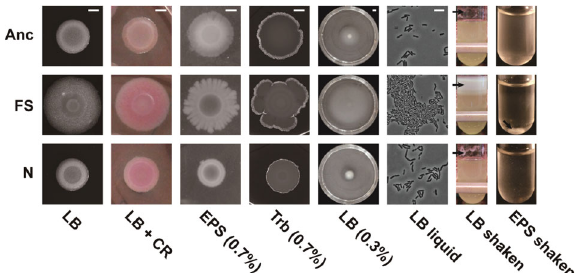
Fig. 2 Phenotypic determination of the evolved variants. From left to right: colony morphologies, Congo red uptake, swarming motility on EPS and Trb medium, swimming motility, cellular morphologies in LB liquid, bio fi lm formation in LB and EPS medium in shaken cultures. Anc, FS, and N indicate the ancestor, FS, and N morph variants, respectively. Scale bars in colony and surface motility images indicate 5 mm and that in single cellular morphol- ogies indicates 10 µm across all groups. Arrows indicate the formed bio fi lm in the LB shaken